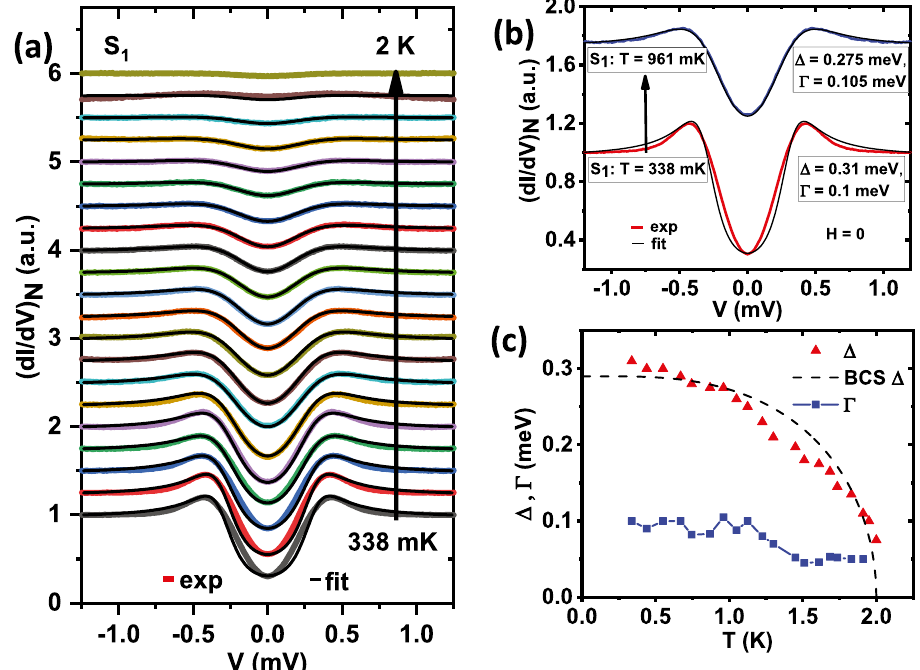
Figure 2. ( a ) Temperature (T) dependence of tunneling conductance spectra S 1 (color lines) with theoretical fits (black lines) in the absence of any magnetic field. ( b ) Spectra S 1 at 340 mK and also at 960 mK along with corresponding fitting parameters, where better fit at higher temperature is visible. ( c ) Evolution of (cid:31) and Ŵ with temperature, extracted from plot (a) along with an ideal BCS trend of (cid:31) for comparison.